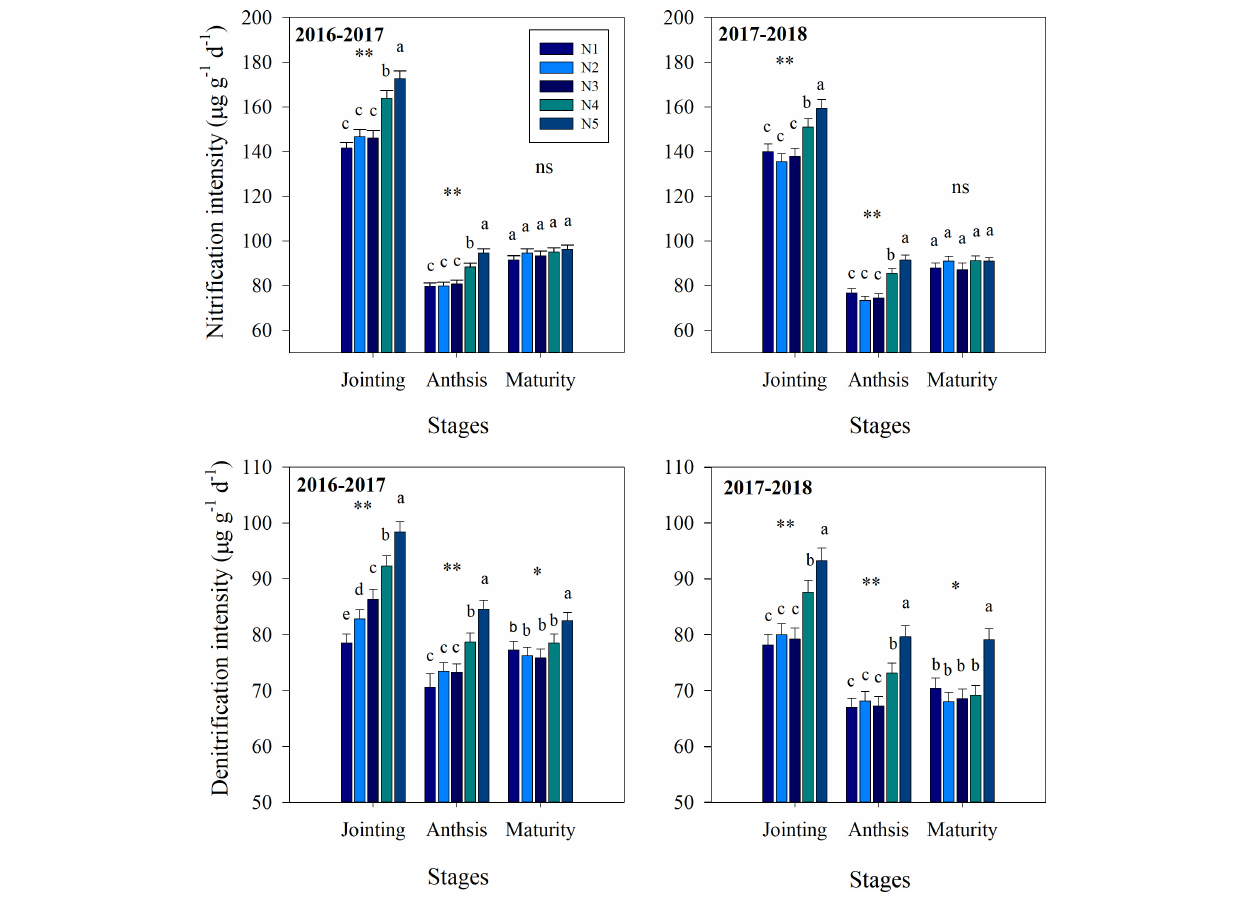
FIGURE 2 | The effects of split nitrogen fertilizer on the nitrification intensity and denitrification intensity. ∗ , ∗∗ significant at the 0.05 and 0.01 probability levels, respectively, ns, no significant. Values followed by different letters within the same stages are significantly different at P < 0.05. N1 (basal/dressing, 100/0%), N2 (basal/dressing, 70/30%), N3 (basal/dressing, 50/50%), N4 (basal/dressing, 30/70%), and N5 (basal/dressing, 0/100%).